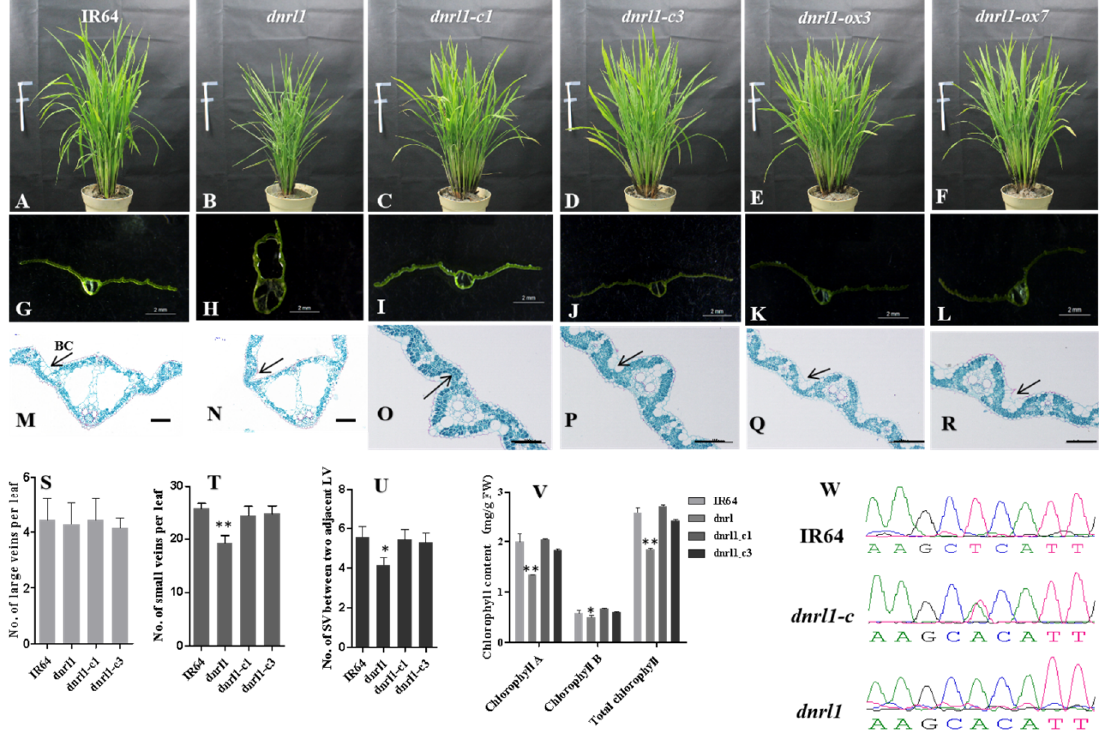
Figure 3. Functional complementation of the mutation. ( A – F ) Nine-week-old IR64 (WT), dnrl1 , complemented and over-expression plants, bar = 10 cm; ( G – L ) leaf blade transverse section of ( A – F ), bar = 2 mm; ( M – R ) slice observation of ( G – L ) (black arrow indicates bulliform cells, BC), for ( M ) and ( N ), bar = 50 µ m; for ( O – R ), bar = 100 µ m); ( S ) number of LV per leaf; ( T ) number of SV per leaf; ( U ) number of SV between two adjacent LV; ( V ) chlorophyll contents of IR64, dnrl1 , dnrl1-c1 and dnrl1-c3 at nine weeks. Values are means ± SD ( n = 3); *indicates significance at p ≤ 0.05; ** indicates significance at p ≤ 0.01 by Student’s t test; ( W ) the nucleotide at the mutation site in IR64, dnrl1 , and complemented plants.